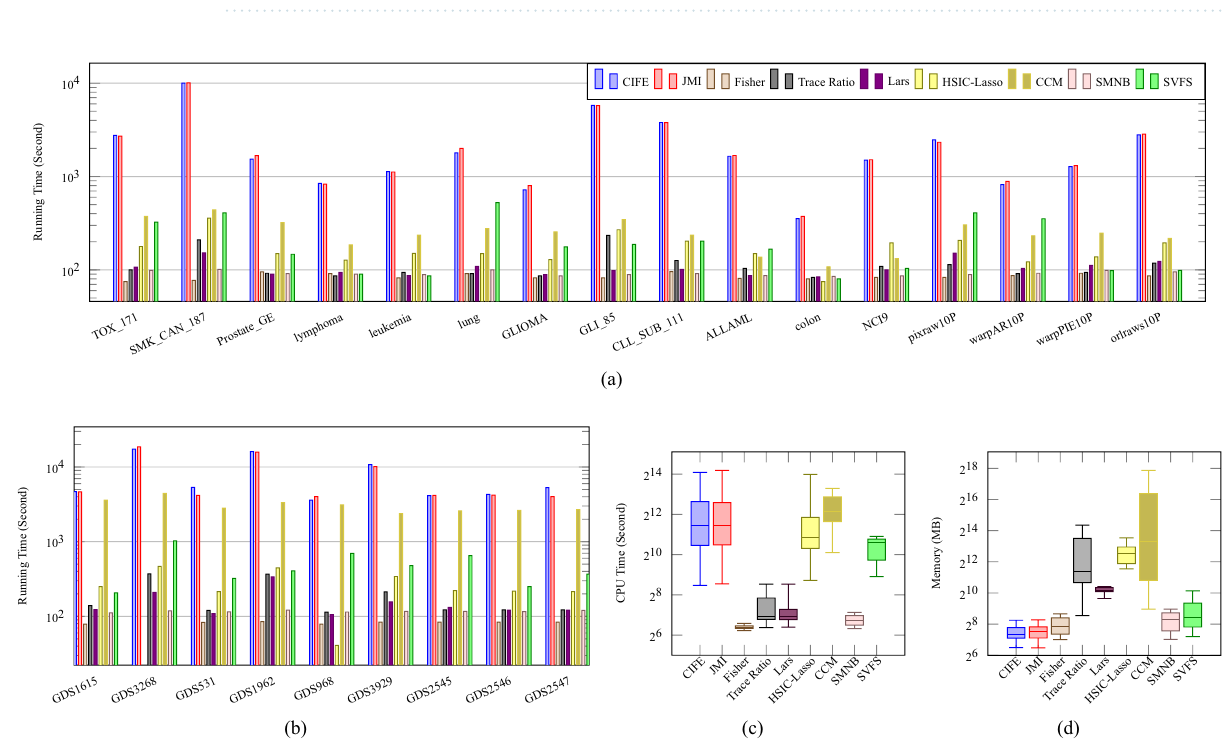
Figure 6. (a), (b) Running Time, (c) CPU Time and (d) Memory taken by CIFE, JMI, Fisher, Trace Ratio, Lars, HSIC-Lasso, CCM, SMNB and SVFS over 10 runs using RF